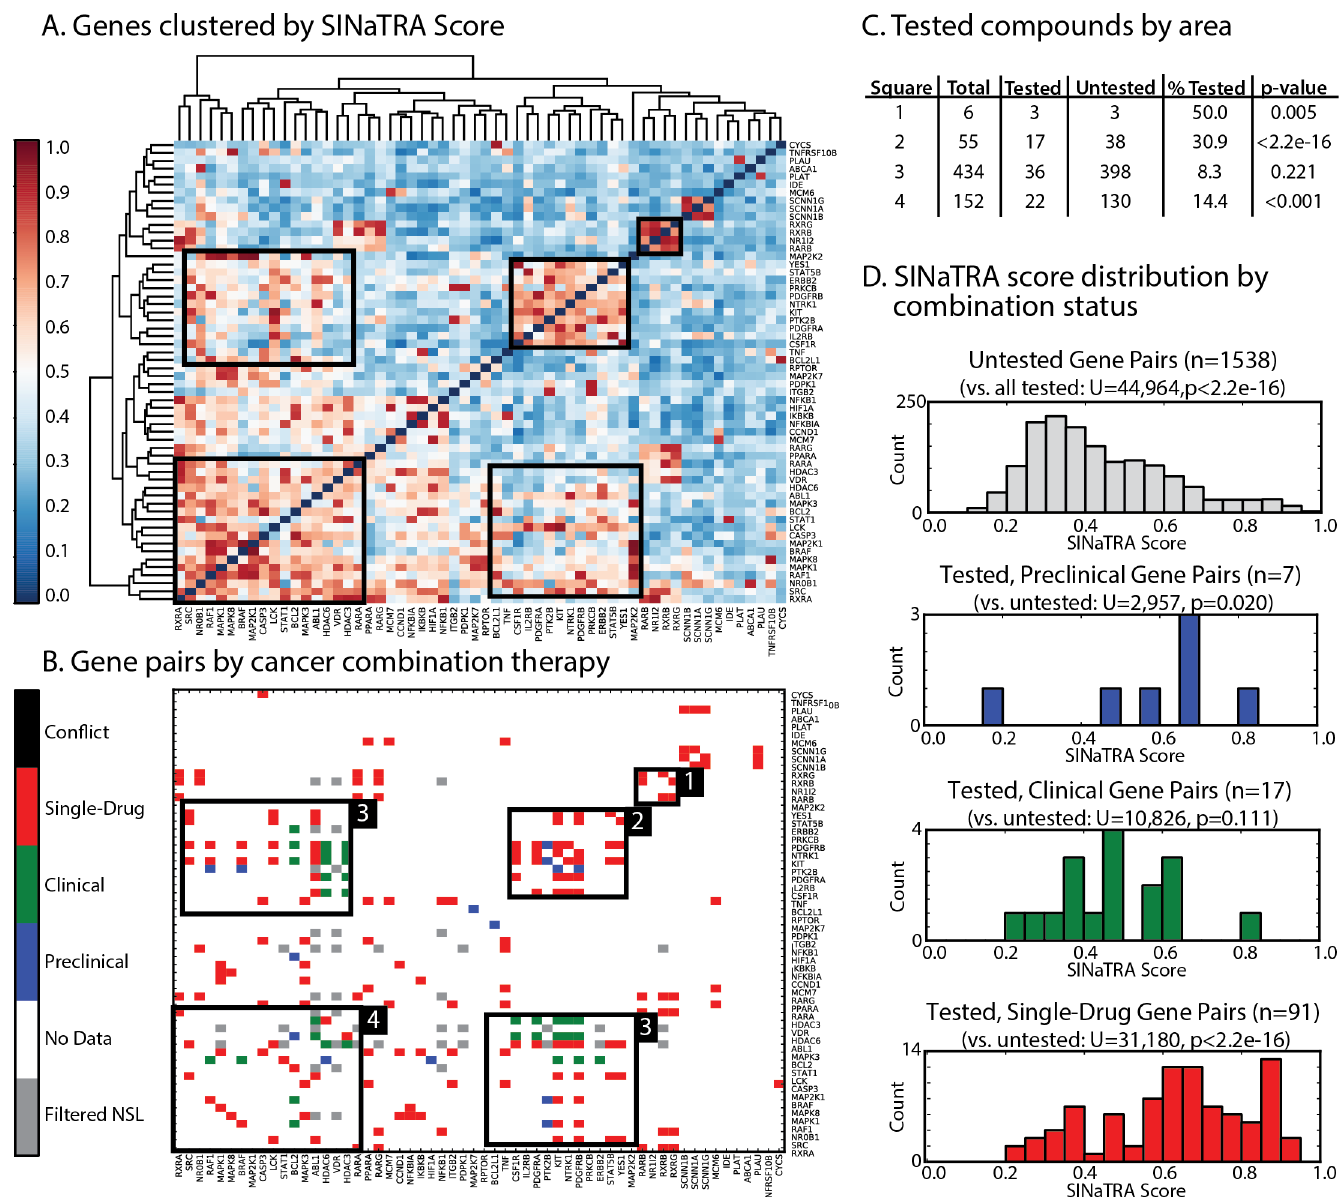
Fig 6. A. Druggable gene pairs clustered by SINaTRA score. Sixty-two unique genes that participated in predicted SL interactions with SINaTRA scores > 0.85, where both genes mapped to drugs in DCDB, were identified. All pairwise SINaTRA scores were computed and clustered by score. Areas of high- and low SINaTRA scores are clearly visible. B. All possible gene pairs identified in Part A were mapped to DCDB, and gene pairs whose products are targeted by single drugs and combination therapies in the clinical pipeline were highlighted (pre-clinical, blue; clinical trials, green; single drug, red; gene pairs filtered out by genetic analysis, gray; filtered gene pairs associated with drugs, black [n = 0]). Areas enriched for drug combinations were highlighted in both parts A and B. C. Enrichment of tested compounds in the four areas of interest were calculated using the Fisher Exact Test, and p-values were calculated. Areas 1, 2 and 4 were significantly enriched. D. Distributions of SINaTRA score by drug